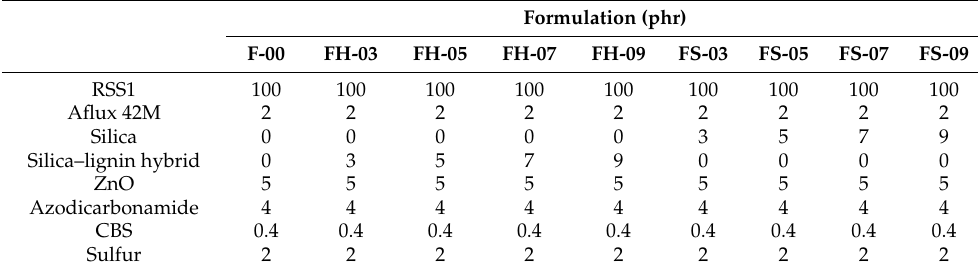
Table 1. Natural rubber foam compounding formulation.